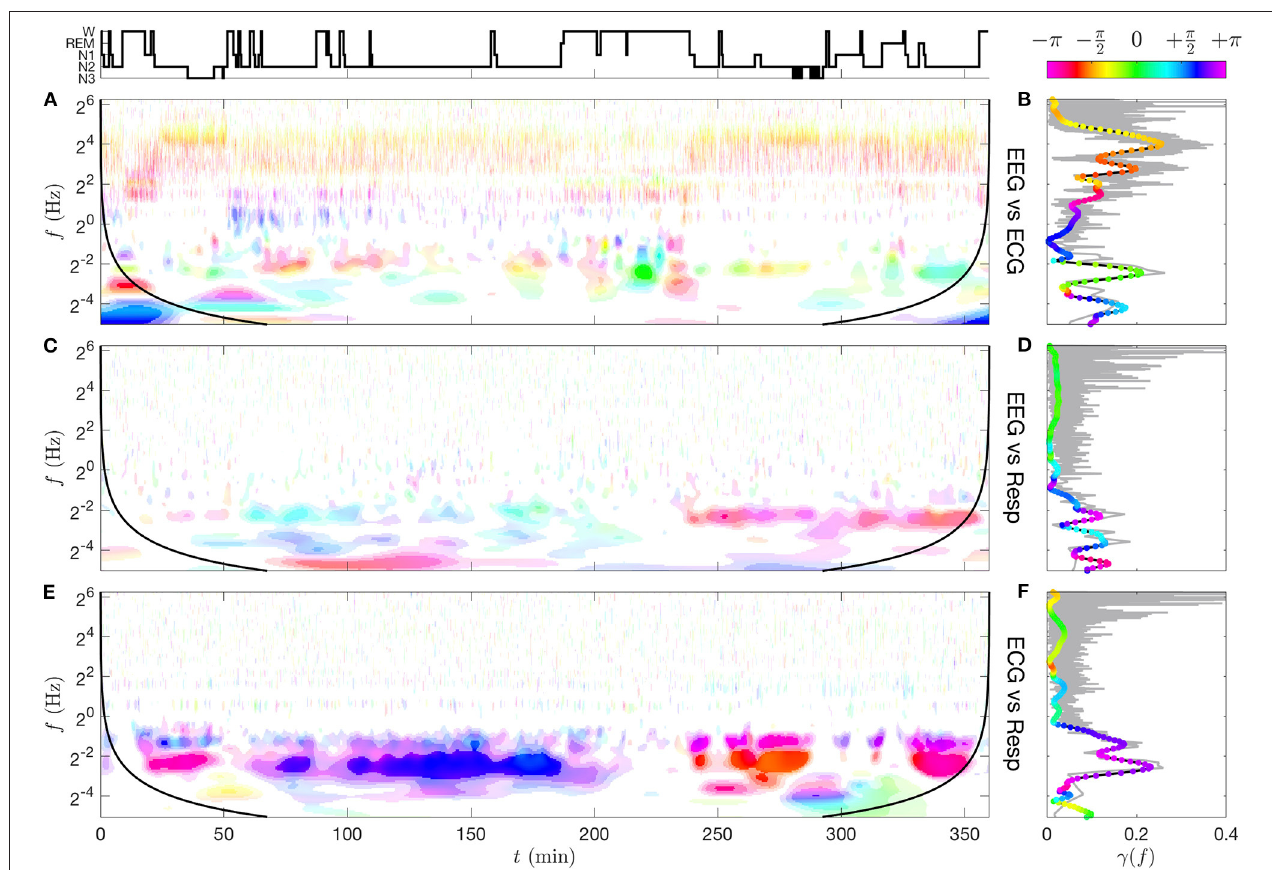
Q , n ) (A,C,E) and spectral coherence γ xy ( f ) (B,D,F) computed from pairs of CWTs (see Supplementary Figure 5 ) for FIGURE 9 | Time-frequency coherence γ xy ( f , t ; subject slp04 from the database slpdb . (A,B) EEG vs. ECG, (C,D) EEG vs. respiration signal, (E,F) ECG vs. respiration signal. The ranges of coherence moduli for the color saturation coding are delimited by the lower thresholds γ (10 − 1 ) 0.21, γ (10 − 3 ) 0.36,0.5,0.7. The wavelet and smoothing kernel parameters are ≈ ≈ Q 5 and n 50. For each coherence image, a black line materializes a distance n δ t from the initial and final times, beyond which border effects are possible. The = = spectral coherence γ xy ( f ) (right column) computed from Fourier transforms (thin gray line for its modulus) is compared to the one computed from CWTs (black line for its modulus and colored dots for its phase). See text for